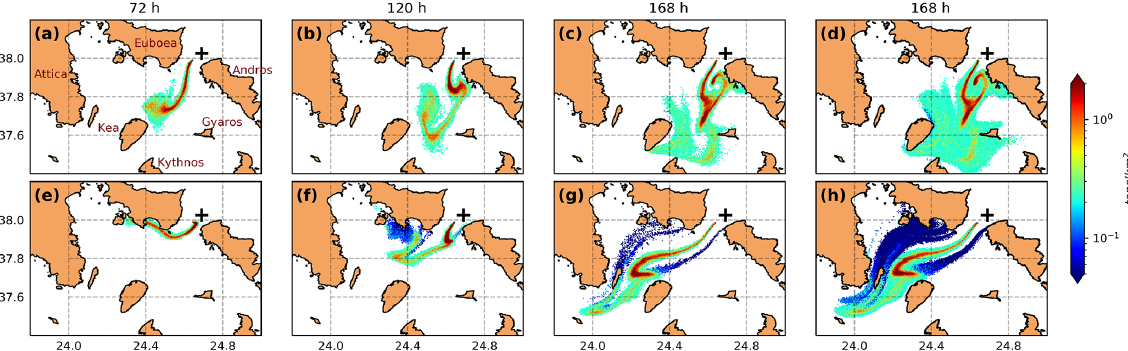
Figure 7. Surface oil concentrations (API 31; t/km 2 ) of the deterministic simulation for (a–c) winter and (e–g) spring at forecast times 72, 120, and 168h; (d, h) the same as (c) and (g) , but for all members of the ensemble at forecast time 168h.